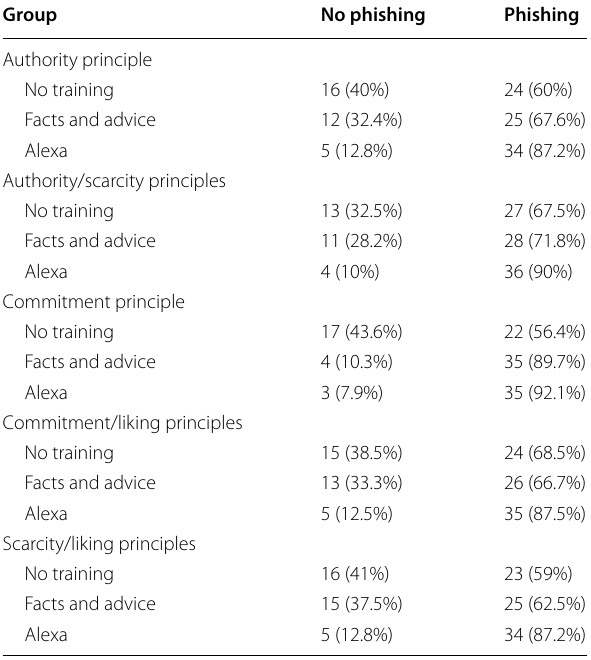
Table 3 Pearson chi-square tests—hypothesis